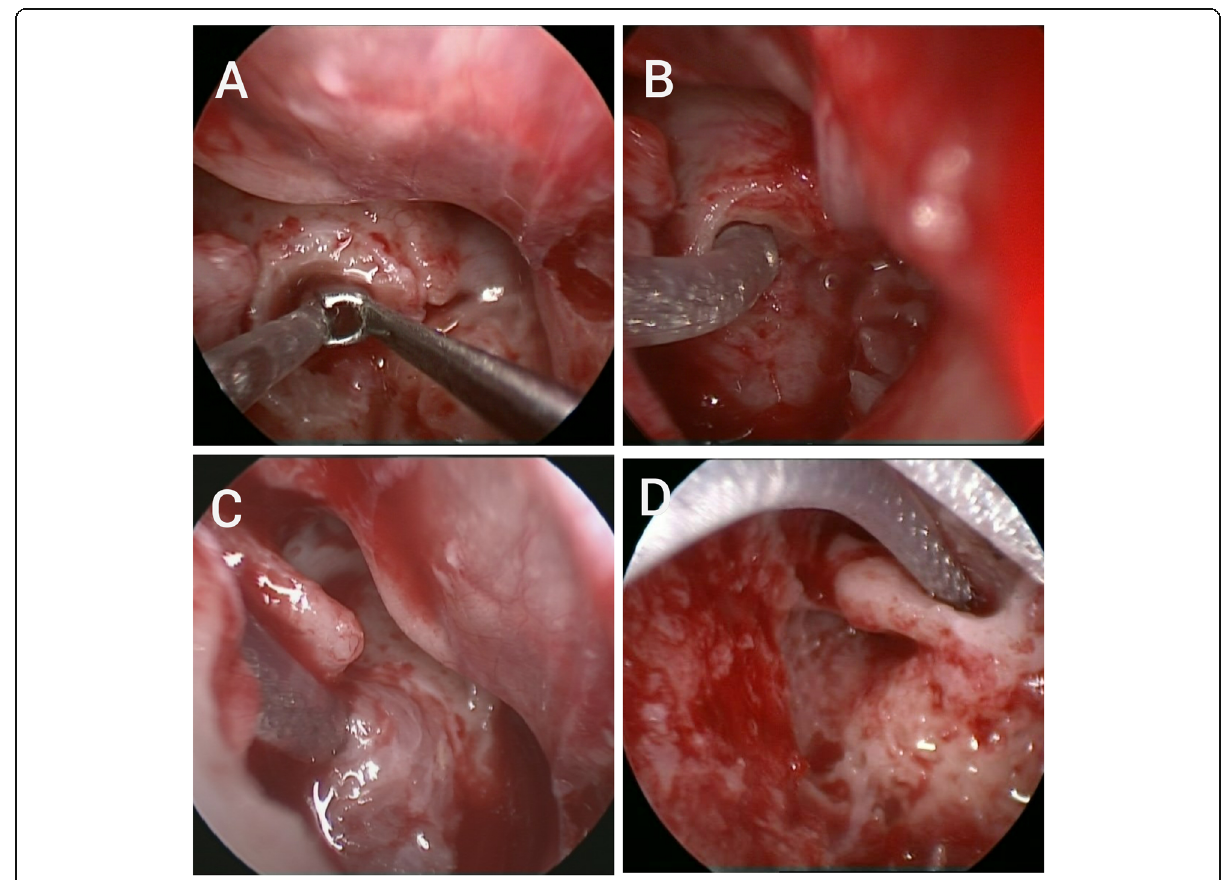
Fig. 4 a Endoscopic view of the electrode insertion into the ST of the basal turn of the cochlea. b , c Endoscopic view of a fully inserted electrode into the RW sealed with piece of periosteum. d Endoscopic view of the final position of the electrode inserted through the (epitympanic)